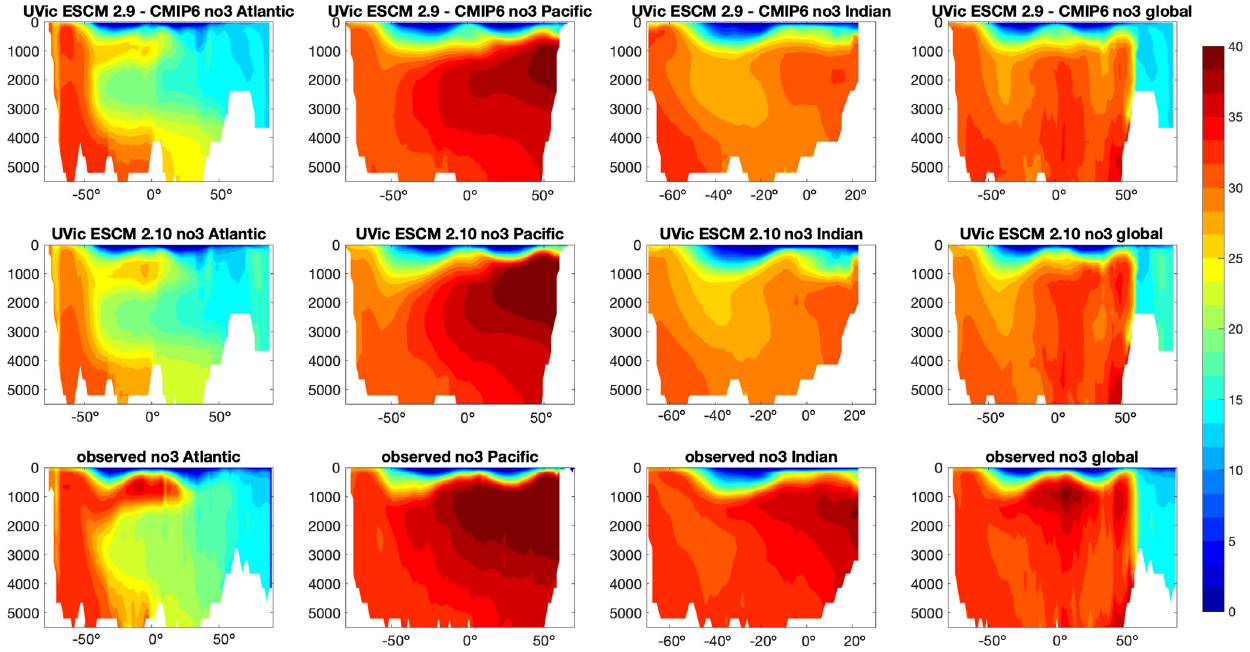
Figure 13. Ocean section of NO 3 (in µmolkg − 1 ) for the Atlantic Ocean including the Arctic Ocean (left column), the Pacific Ocean (middle left column), the Indian Ocean (middle right column) and the global average (right column) compared to the World Ocean Atlas 2018 (Garcia et al., 2019). From top to bottom, what is shown are the published UVic ESCM version 2.9 by Eby et al. (2013) spun up and forced with CMIP6 forcing, the UVic ESCM version 2.10, both as a mean of the period 1980–2010, and the observed ocean sections.